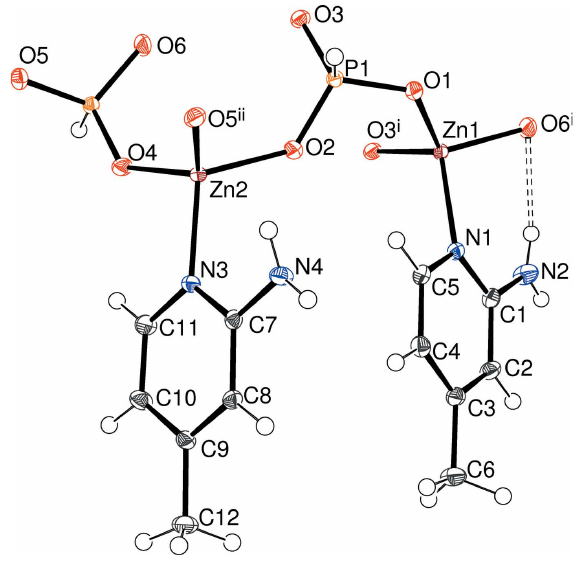
Figure 2 The asymmetric unit of (II) expanded to show the complete zinc-atom coordination spheres showing 50% displacement ellipsoids. Symmetry (cid:5) x , 1 (cid:5) y , 1 (cid:5) z ; (ii) 1 (cid:5) x , y , 3 codes: (i) 1 2 2